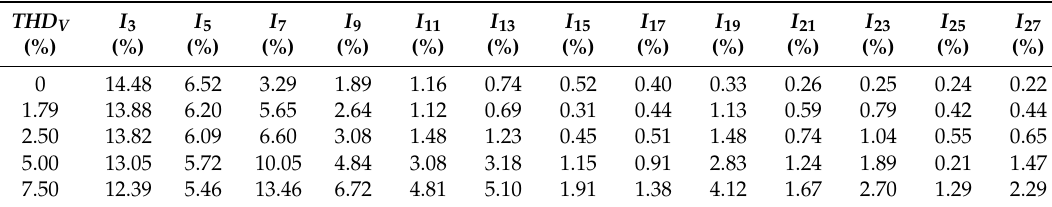
Table 8. List of measured selected RMS values of harmonics I h in relation to the basic harmonics for LED2.